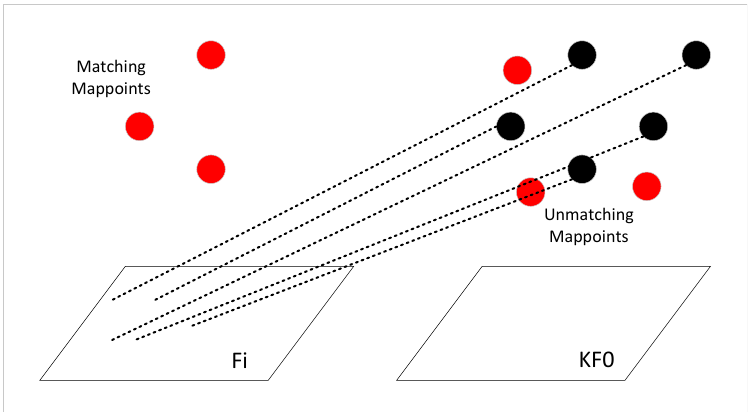
Figure 2. Reprojection of mappoints. The red points is the mappoints that has been matched between the two frames, and the black points is the unmatched mappoints. This process is used to generate new matching